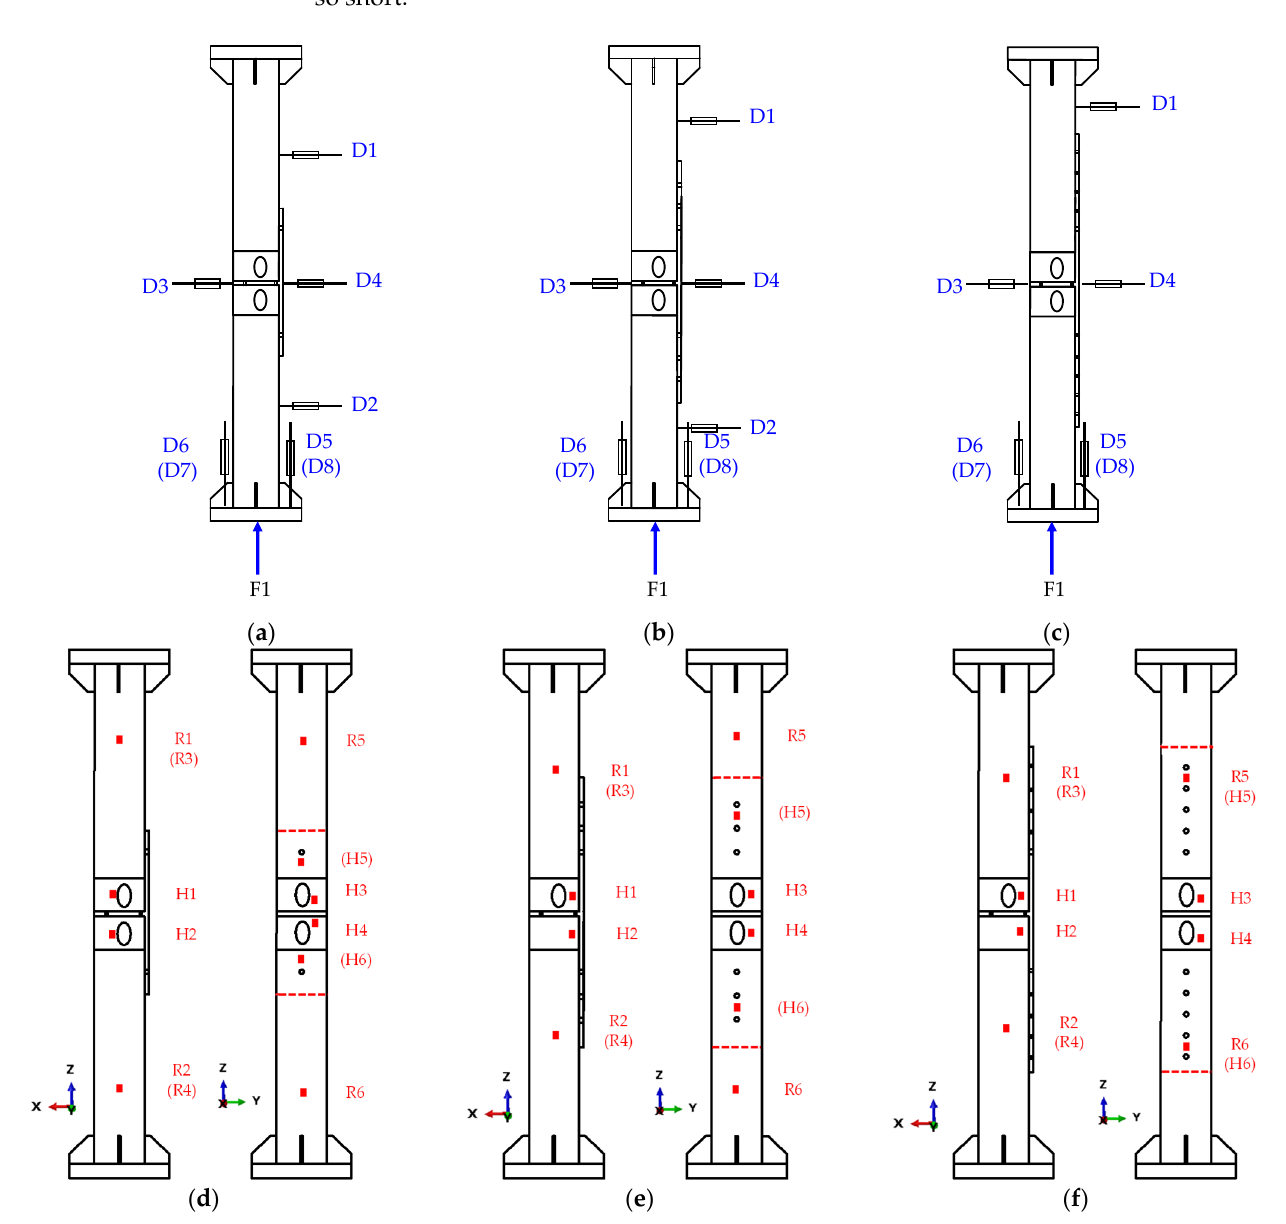
Figure 9. Layout of transducers: ( a ) locations of LVDTs for SC-1; ( b ) locations of LVDTs for SC-2~SC-4; ( c ) locations of LVDTs for SC-5; ( d ) SC-1 strain gauge measurement; ( e ) SC-2~SC-4 strain gauge measurement; ( f ) SC-5 strain gauge measurement. Notes: R denotes strain rosette; H denotes strain gauge; () denotes strain gauge was attached to the reverse side.